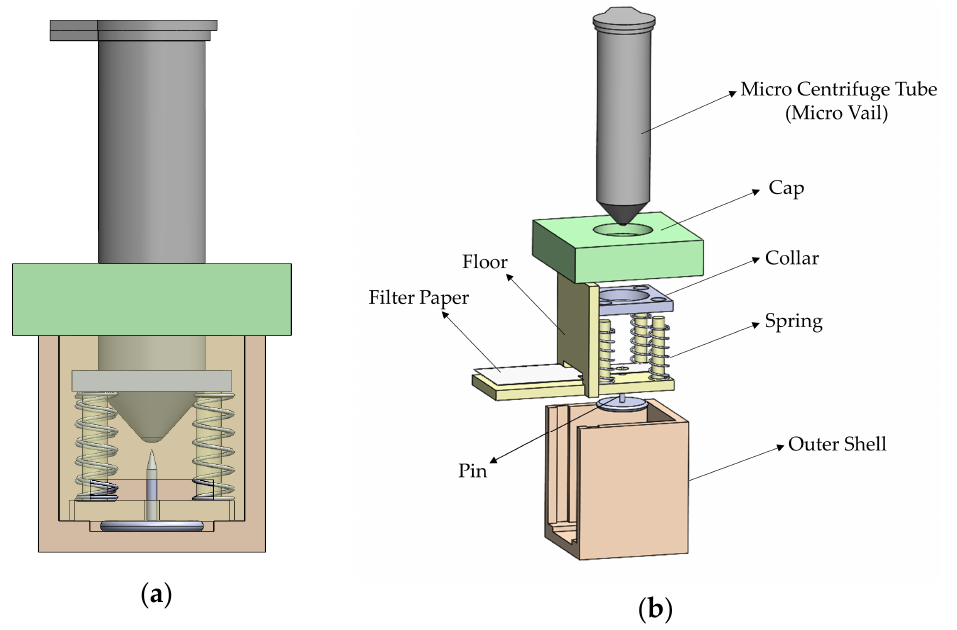
Figure 3. ( a ) A side view of the release mechanism. The inside of the outer shell appears by making the side part transparent. ( b ) An exploded view of the mechanism.